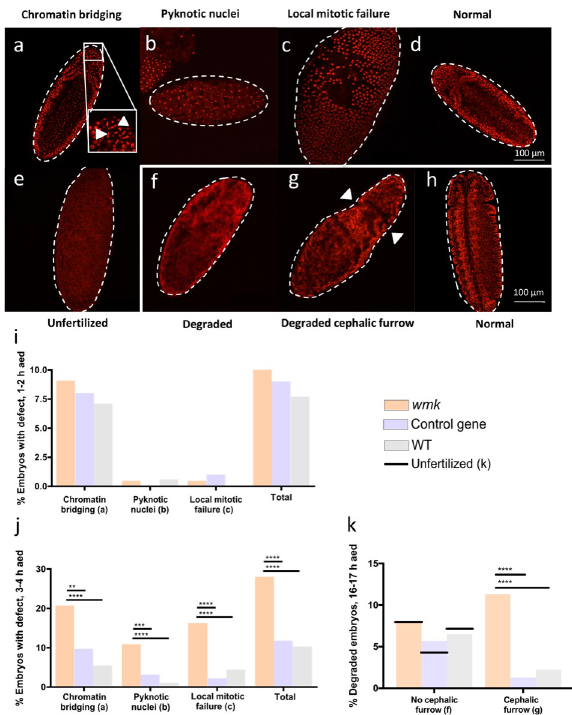
Fig 3. Transgenic expression of wmk causes cytological defects in early embryogenesis. Data are from pooled embryos (both sexes, expressing and non-expressing) with either wmk , the control gene, or an uninfected wild type (WT) background (see methods). (A-C) Defective wmk embryos fixed 3–4 h after egg deposition (AED) exhibit either chromatin bridging (arrowheads), pyknotic nuclei, or local mitotic failure leading to gaps in the distribution of nuclei, respectively. (B) Image has been brightened for visibility. (D) Image of a normal control gene embryo fixed 3–4 h AED. (E) Image of unfertilized embryo fixed approximately 3–4 h AED. (F) Image of degraded wmk embryo fixed 16–17 h AED with no distinct nuclei and no visible segmentation. (G) Image of a degraded wmk embryo fixed 16–17 h AED with no distinct nuclei, but the cephalic furrow is (indicated by arrowheads). (F) and (G) are brightened in order to see their differences. (H) Image of normal control gene embryo fixed 16–17 h AED. (I) Graph quantitating the percentage of embryos exhibiting DNA defects that were fixed 1–2 h AED. N = 220 for the wmk cross, N = 200 for the control gene cross, and N = 169 for the WT cross. Total refers to the total percentage of embryos with one or more of the three defects (embryos can have more than one, as in (A)). All differences within each defect category were not statistically significant. (J) Graph of the percentage of embryos exhibiting DNA defects that were fixed 3–4 h AED for wmk , control gene, and WT crosses. N = 276 for the wmk cross, N = 273 for the WT cross, and N = 279 for the control transgene cross. (K) Graph of the percentage of degraded embryos fixed 16–17 h AED in the wmk , control gene, and WT crosses. N = 327 for the wmk cross, N = 315 for the control transgene cross, and N = 231 for the WT cross. The percent of unfertilized eggs is the expected percent given the observed rate of unfertilized sibling eggs fixed 3–4 h AED ( wmk , 8%, N = 324; control gene, 4.5%, N = 202; WT, 7%, N = 217). Statistics for (I), (J), and (K) were performed with a Chi-square test comparing the three genotypes within each defect category. These experiments have been performed once. The white border around (F, G, & H) indicates embryos fixed 16–17 h AED, while the rest (A-E) are embryos fixed 3–4 h AED. All images were taken at 20X zoom, except the inset image in (A) that is a zoomed in image of the same region. �� p < 0.01, ��� p < 0.001, ���� p <